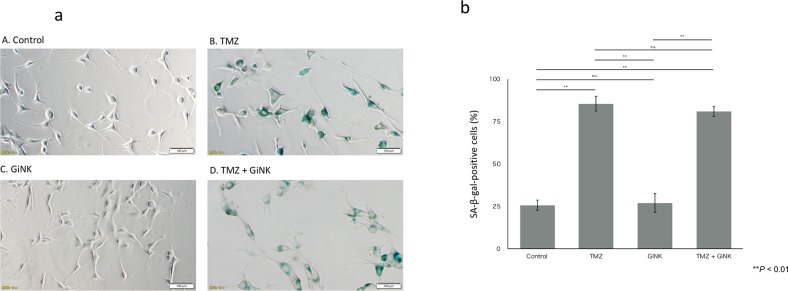
Senescence-inducing effects of TMZ on GBM cell lines in vitro.U87MG cells were seeded at 1 × 104 cells/well in 12-well flat-bottomed plates. U87MG was exposed to GiNK at a GiNK:GBM cell ratio of 1:1 in the presence/absence of 50 μM TMZ for 96 h. Adherent cells were stained with SA-β-gal, and the stained cells were counted under an inverted microscope. (a) Representative photographs of SA-β-gal-stained U87MG cells under each treatment condition. (b) The graphs show the percentages of SA-β-gal-positive cells of U87MG (n = 4) cells. Data indicated as mean ± SE. P values were determined using one-way ANOVA followed by Tukey’s test. Statistically significant differences: **P < 0.01.